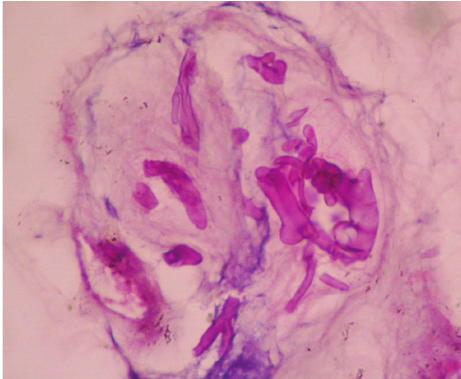
Figure 5: PAS staining of tissue section showing thin, dichotomous hyphae intermingled with wide, irregular aseptate hyphae